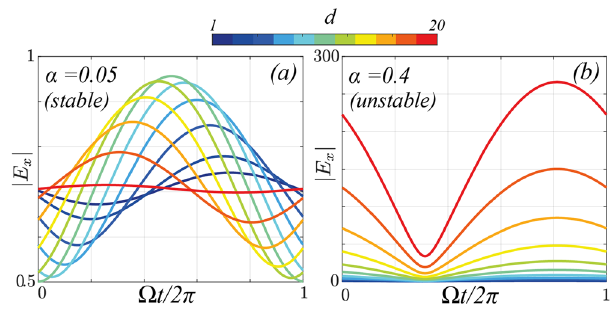
Fig. 8 Modulus of the transmitted electric fi eld as a function of time in (a) the stable phase ( α = 0.05) and (b) the unstable phase ( α = 0.4). In the stable phase, the screw is not capable of capturing the wave's polarisation, which results in periodic oscillations. In the unstable phase, the polarisation of the wave is interlocked with that of the screw, which can thus grab hold of the polarisation of the waves and amplify them as they propagate through it. Here we use ω = 1, Ω = 0.8, g = 1 and ϕ =